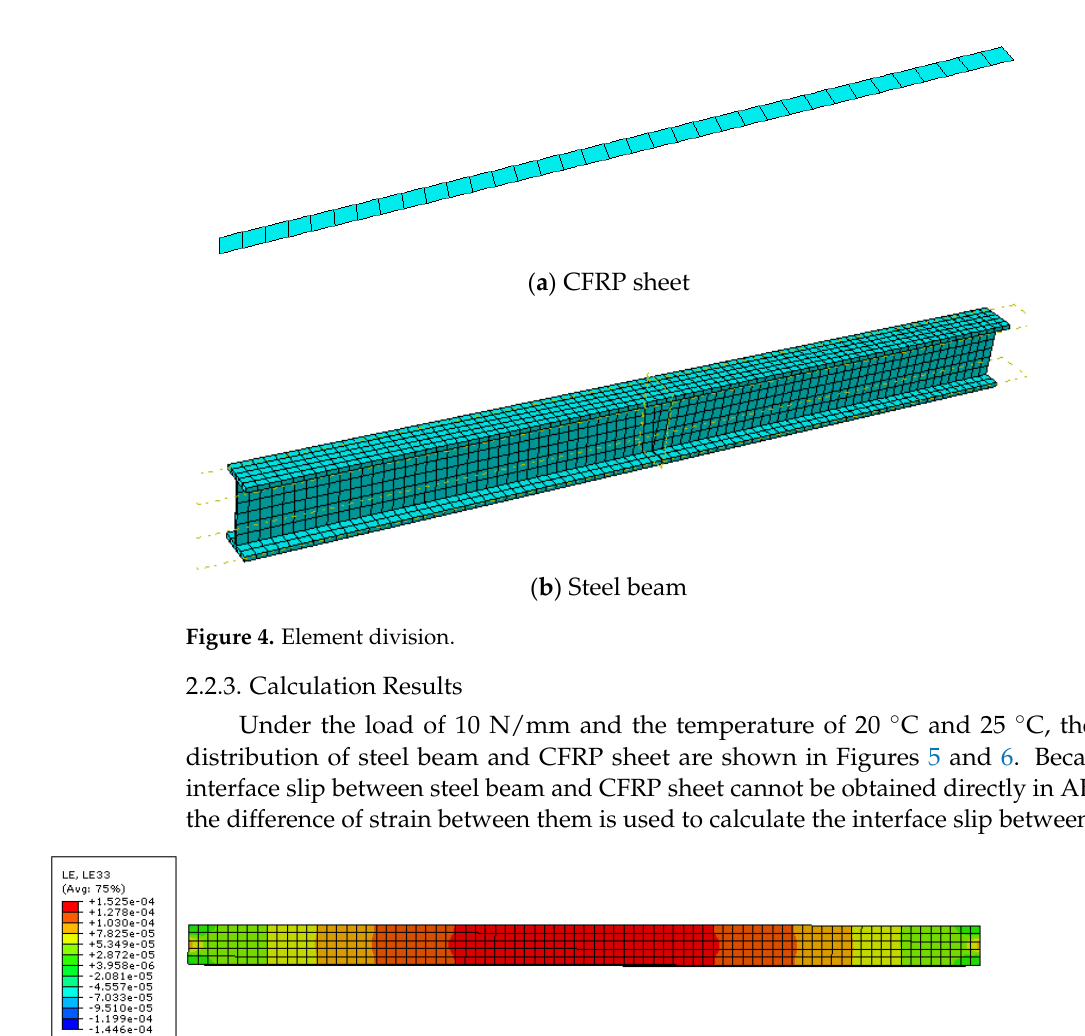
Figure 4. Element division.